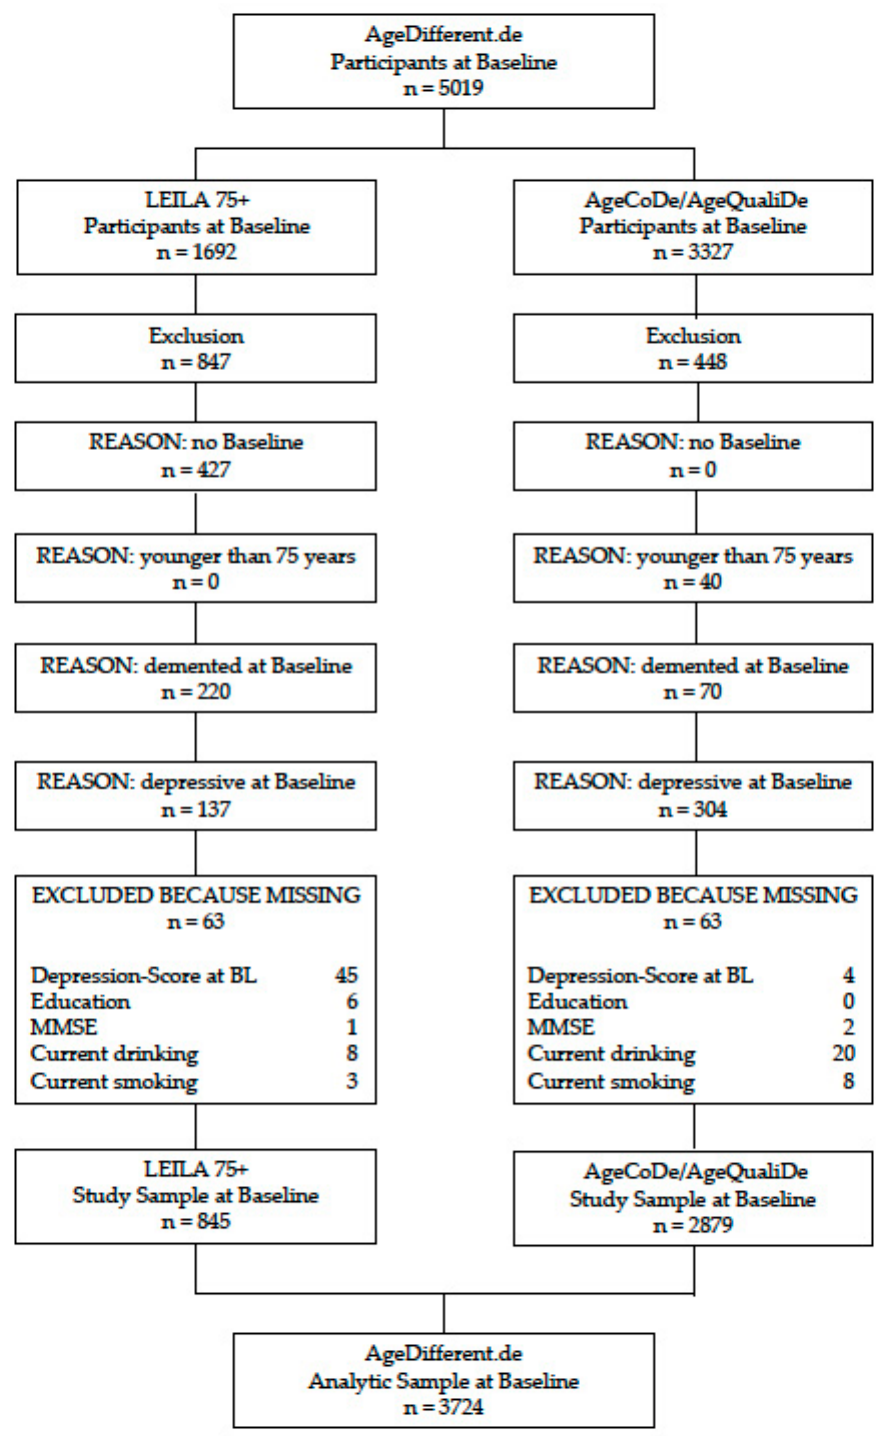
Figure 1. Flowchart of the sample.